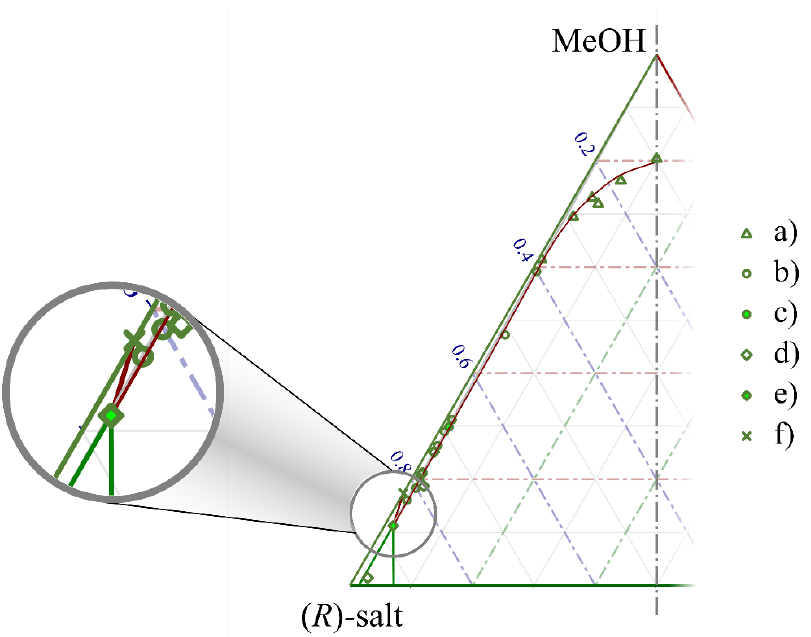
Figure 4. The estimated ternary solubility plot (shown along its axis of symmetry) of benzylammonium mandelate at ambient pressure and 1 ◦ C using methanol as a solvent. ( a ) Nearly racemic crystals and scalemic mother liquor (boundary of zone 1); ( b ) scalemic crystals and eutonic mother liquor (boundary of zone 2); ( c ) average of the points in dataset ‘b’; ( d ) nearly enantiomeric crystals and scalemic mother liquor (boundary of zone 3); ( e ) average of the data in ‘d’; ( f ) solubility of the pure enantiomer (the scaling on the side of the diagram corresponds with 100 times the mole fraction of the given species).